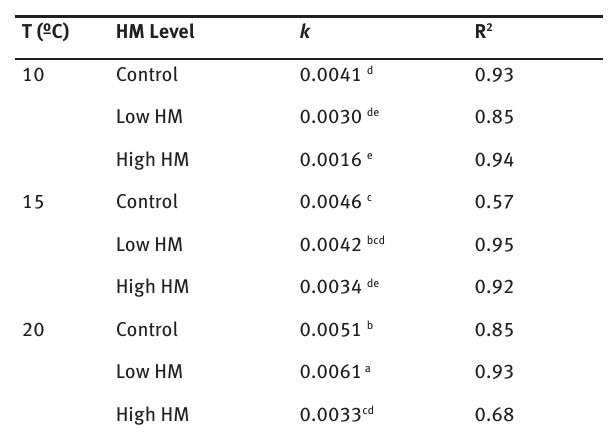
Table 1: Decomposition rates ( k ) of Typha leaf incubated in microcosms at different temperature (T) and low or high heavy metal (HM) level for 100 days, and coefficient of determination (R 2 ) of the regression.